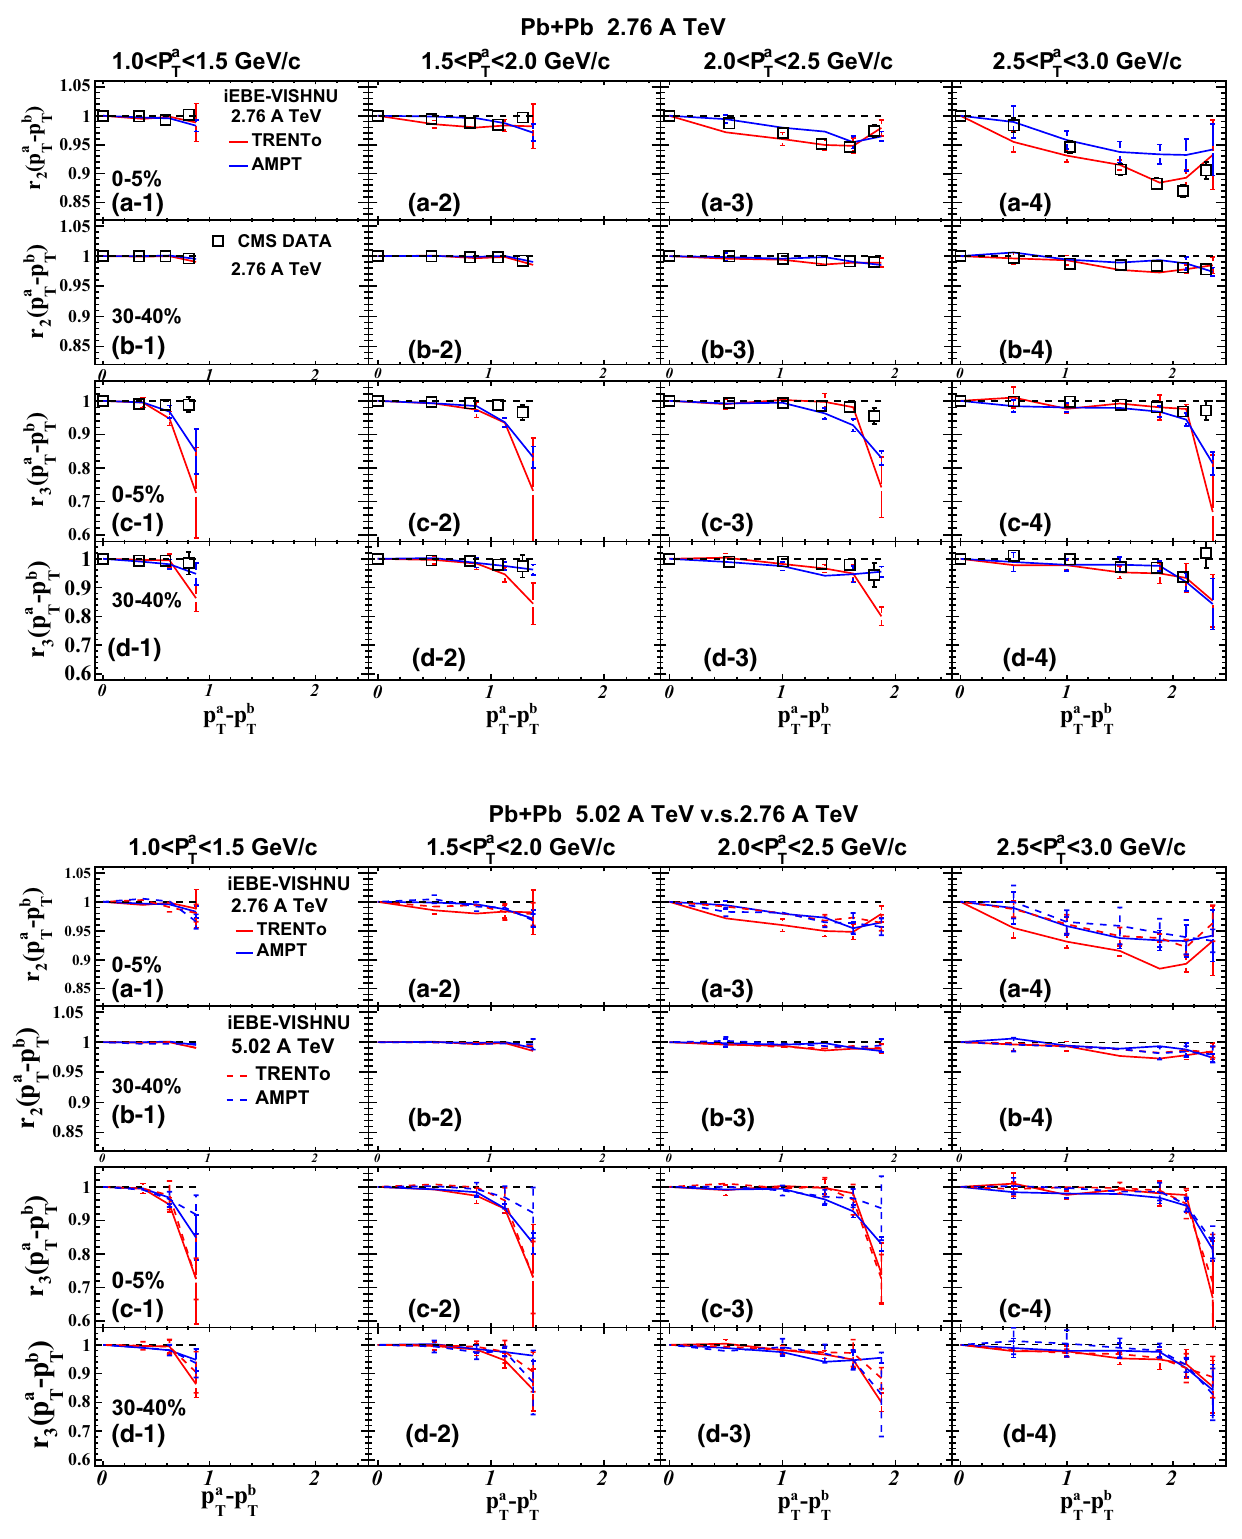
− p b in 0–5 and 30–40% Pb + Pb collisions at 2.76 and 5.02 A TeV, calculated from T T